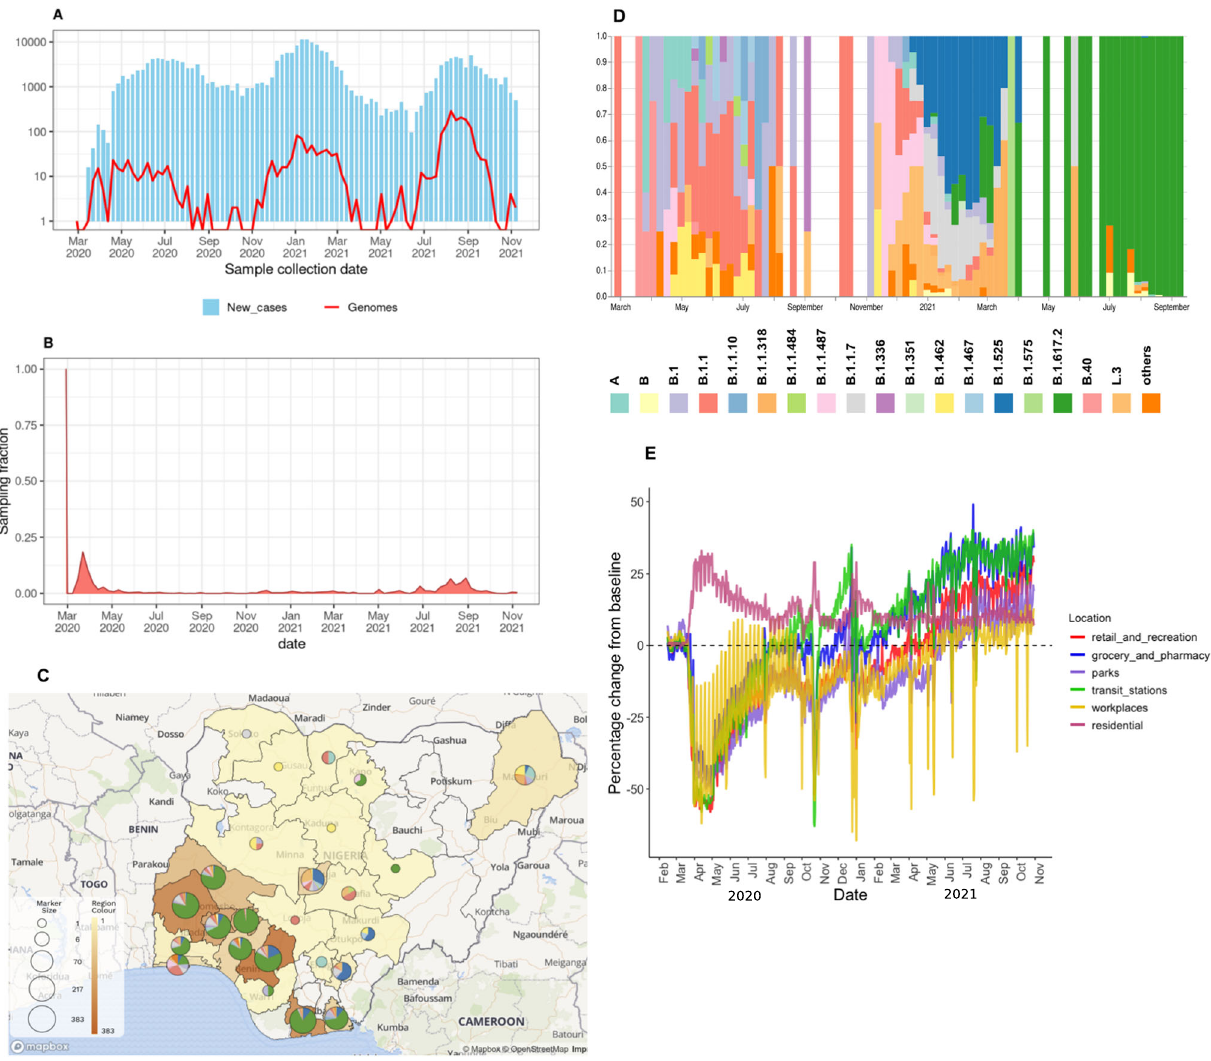
Fig. 1 | Genomic epidemiology of SARS-CoV-2 in Nigeria. A Epicurve of SARS- CoV-2casesinNigeriainNigeriaandgenomesproducedassembledduringthe fi rst three waves with the y-axis transformed to a log-scale. B Time-varying sampling fraction of genomes produced in this study per new cases. C Geographic dis- tribution of sequences generated in the current study. The map of Nigeria shows thenumberofgenomesfromstatesacrossthecountryasregioncolourandmarker size display lineages per state. Maps © Mapbox (www.mapbox.com/about/maps) and © OpenStreetMap (www.openstreetmap.org/about). D Lineage frequency